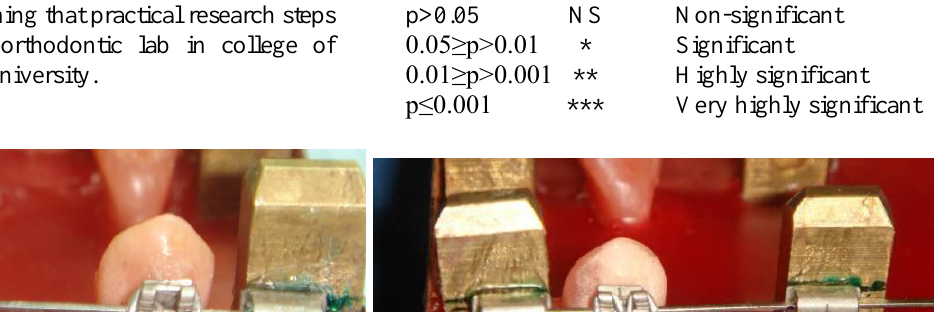
a. figure-O elastic ligature b. figure-8 elastic ligature